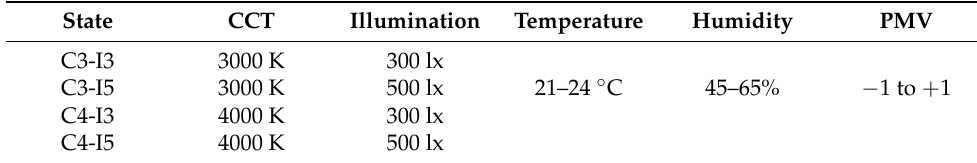
Table 2. Physical parameters of experimental